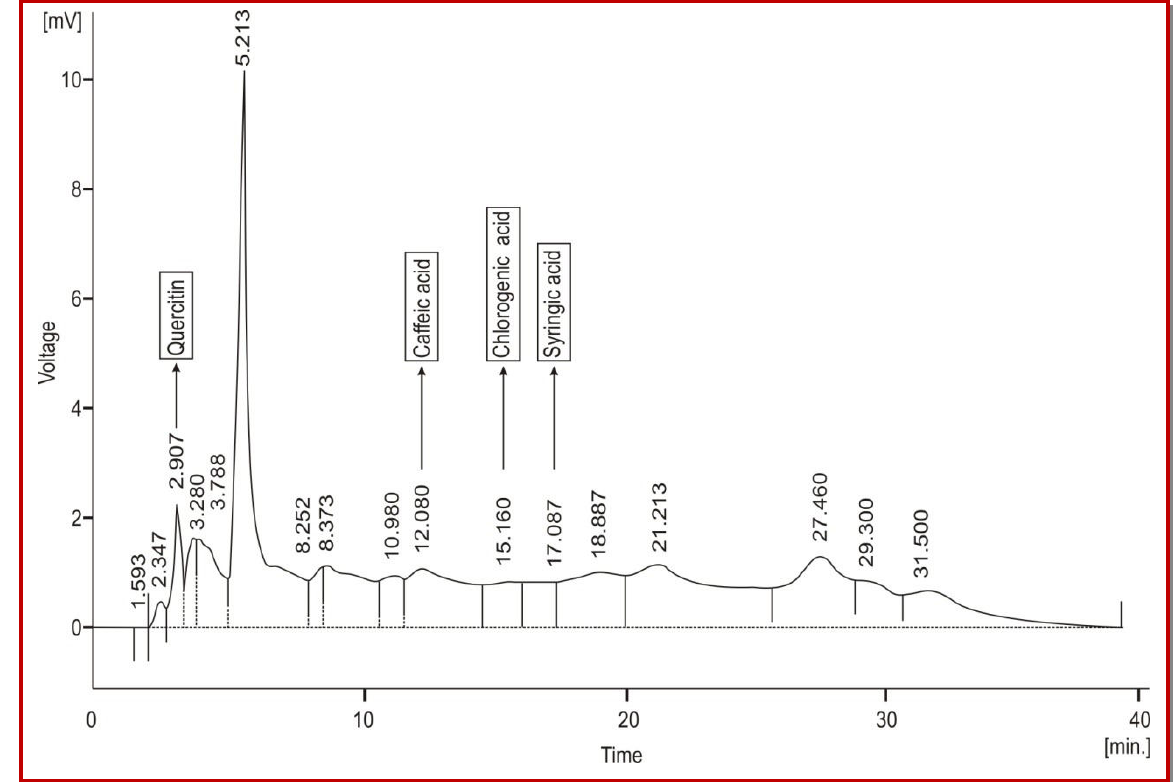
Figure 2: HPLC profile of phenolics in n- butanol fraction of A.